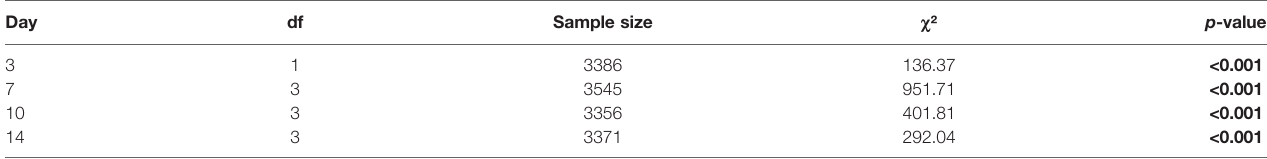
Signi fi cant differences are in